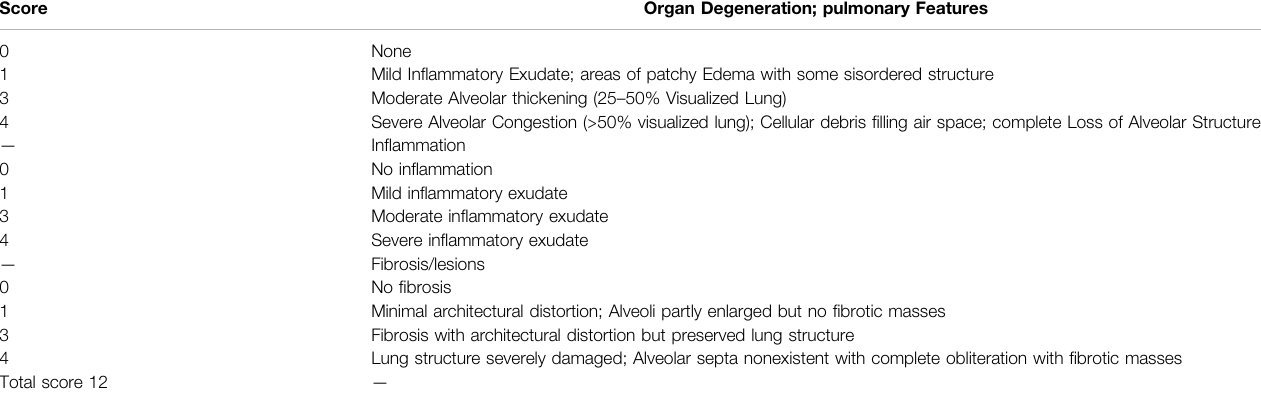
TABLE 1 | Histology activity score for scoring lung sections. Score Organ Degeneration; pulmonary Features 0